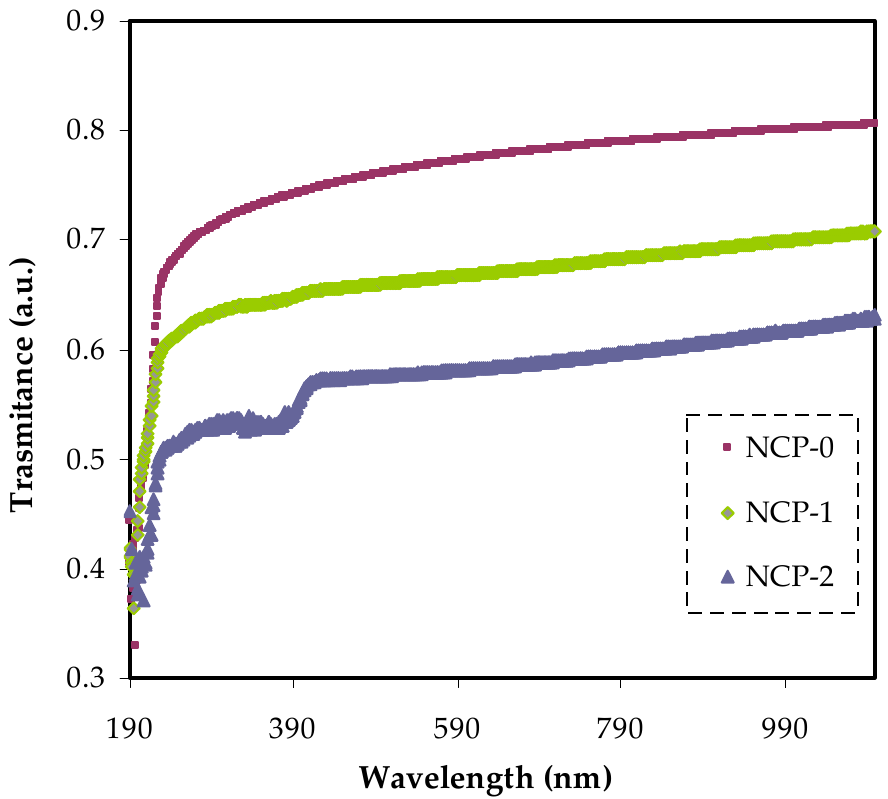
Figure 4. The transmittance of NCP-0 and composite samples.